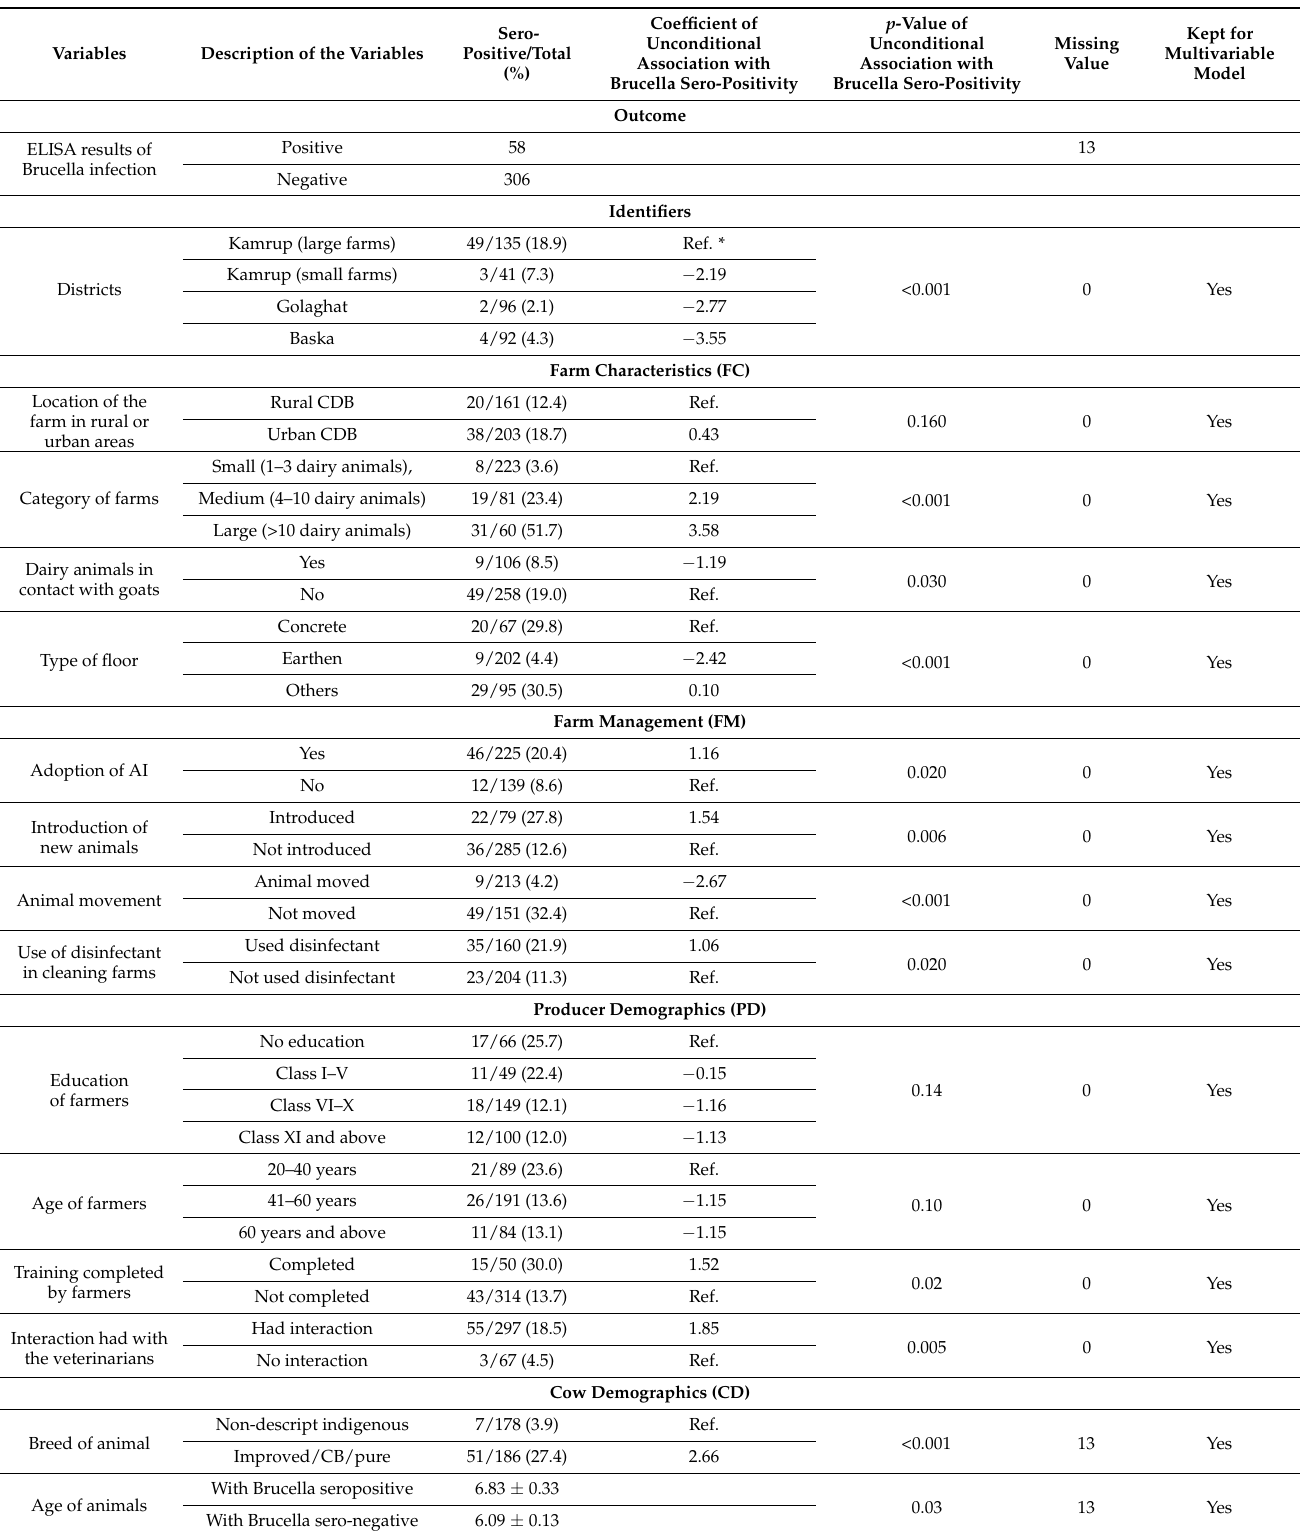
Table 3. Selected variables for multivariable model building with their